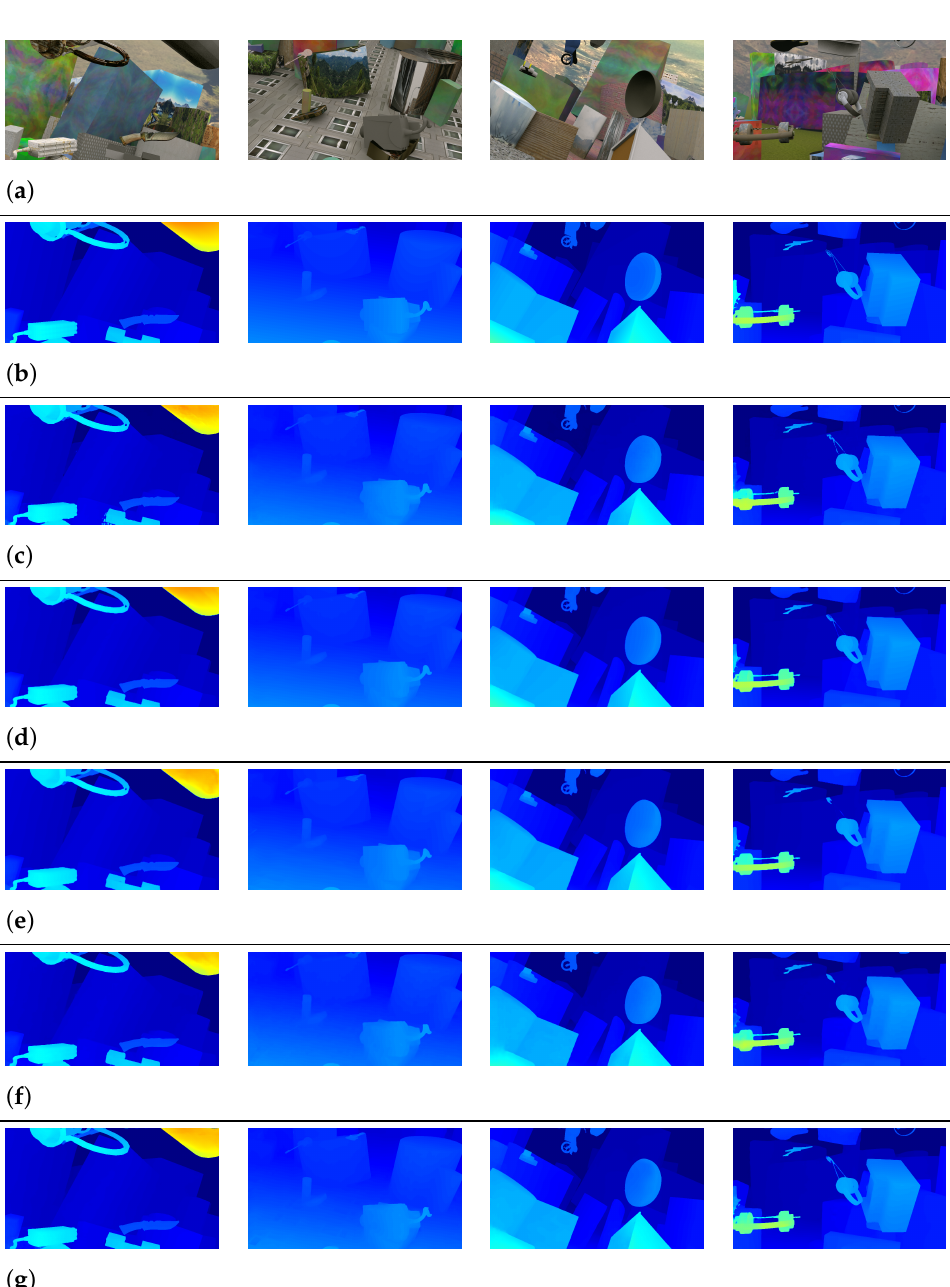
Figure 9. Qualitative comparison on the Scene Flow test set. ( a ) Input Image. ( b ) Ground-truth image. ( c ) PSMNet [12]. ( d ) DeepPruner-Fast [26]. ( e ) SFFNet [17]. ( f ) 2D-MobileStereoNet [28]. ( g )